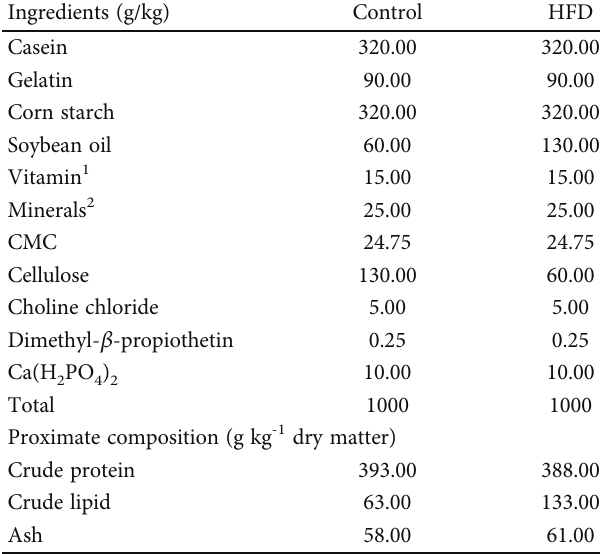
Table 1: The formulation and proximate analysis of experimental